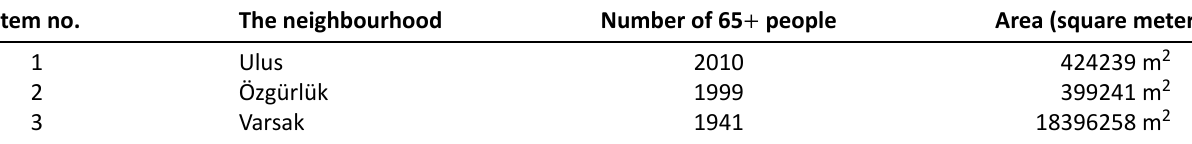
Table 5. 65 + population and area size of neighbourhoods.